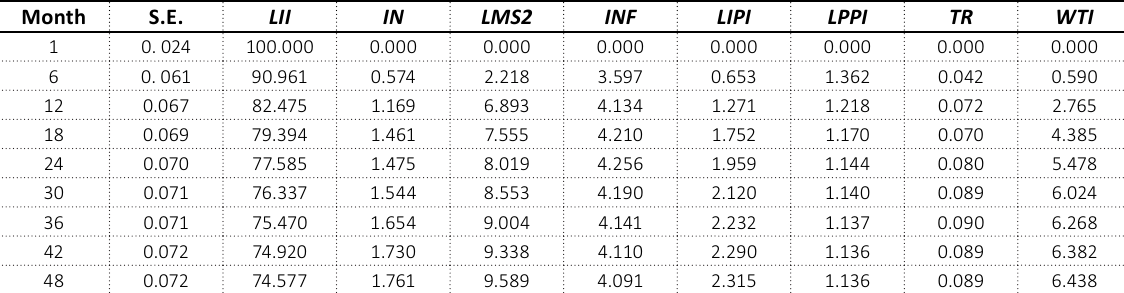
Table 8. VDA of the explanatory variables in industrial index